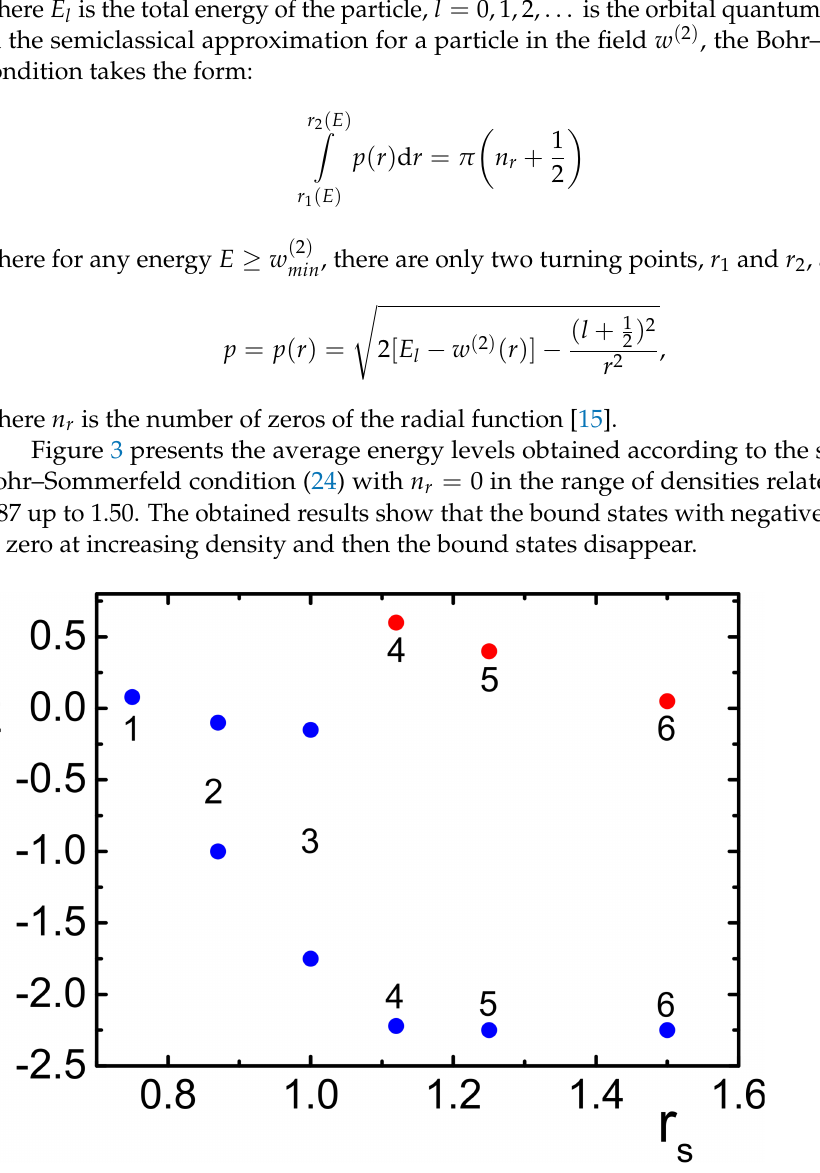
Figure 3. (Color online) Some average exciton energy levels at orbital quantum number l = 0 (blue circles) and at l = 1 (red circles) for Θ = 4. Circles: 1— E 0 = 0.08 at r s = 0.75; 2— E 0 = − 1 and E 0 = − 0.10 at r s = 0.87; 3— E 0 = − 1.75 and E 0 = − 0.15 at r s = 1; 4– E 0 = − 2.22 and E 1 = 0.8 at r s = 1.12; 5— E 0 = − 2.25 and E 1 = 0.50 at r s = 1.25; 6— E 0 = − 2.25 and E 1 = 0.05 at r s =